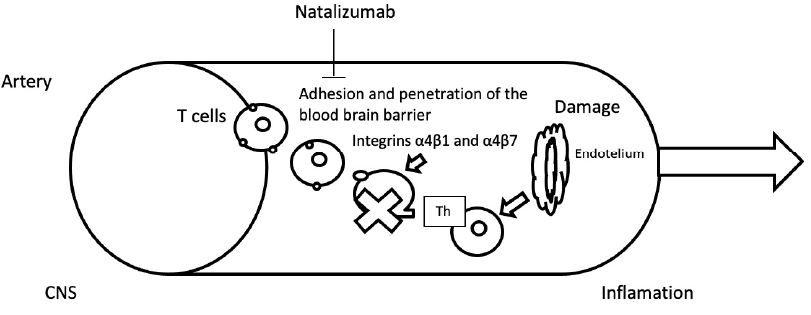
Figure 3. Mechanism of action of natalizumab.